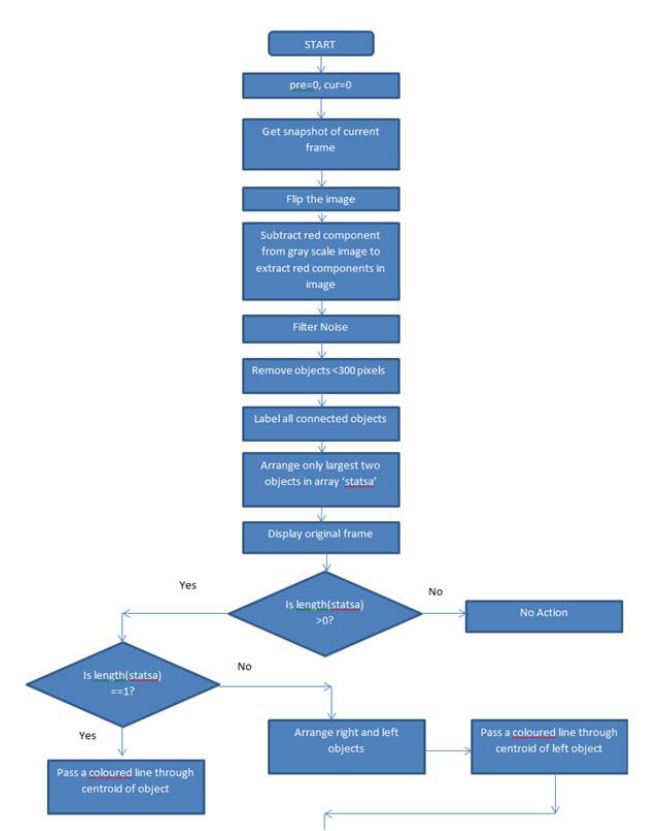
Figure 1 . Project Flowchart - Part